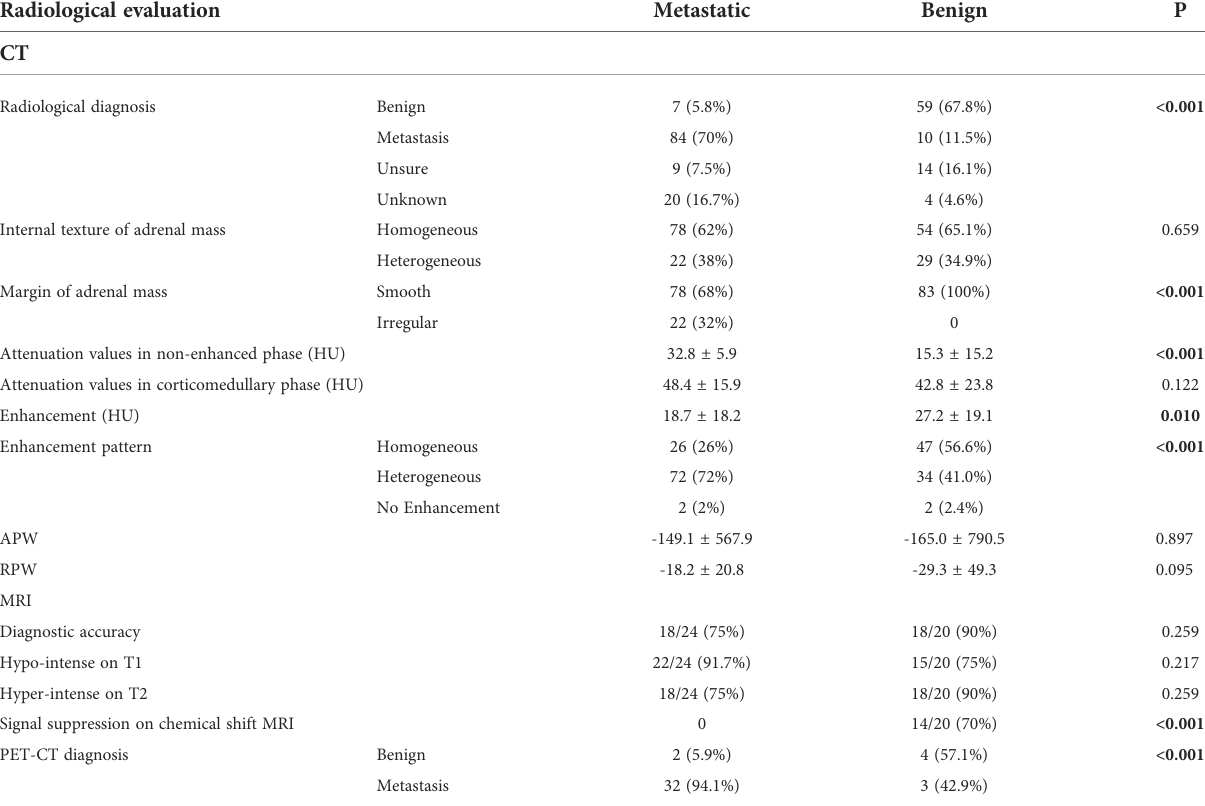
CT, computed tomography; MRI, magnetic resonance imaging; HU, Houns fi eld unit; PET-CT, positron emission tomography-computerized tomography; APW, absolute percentage washout; RPW, relative percentage